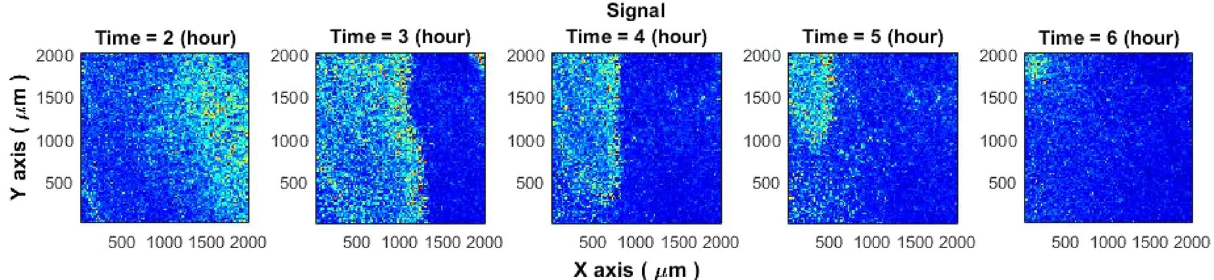
Figure 11. Speckle imaging of the drying agar (agar media without bacteria) in a Petri dish.